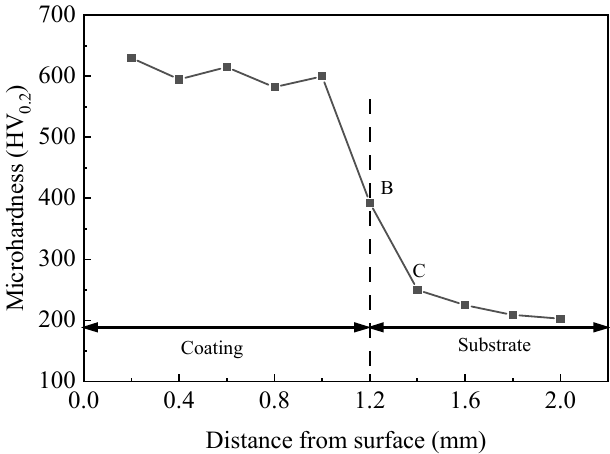
Figure 17. The microhardness variation along the depth